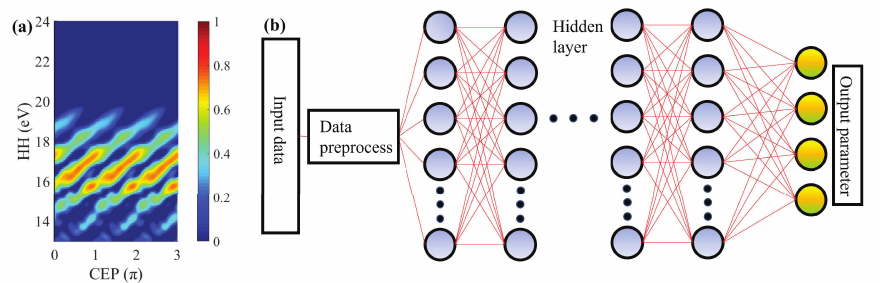
Figure 1. ( a ) CEP dependence of HHG from MgO calculated by the SBE. The theoretical calcula- tions reproduce very well the experimental results presented in [27]. For a better comparison with the experimental data, a laser with field strength of 1.2 V/ ˚A and excitation carrier wave central wavelength of 1.7 µ m, corresponding to a laser period T 0 = 5.665 fs was used. In the numerical simu- lations, a Gaussian shaped envelope with FWHM = 2 T 0 was adopted. MgO band was calculated by Equation (1) with rp 1 = 7.78, rp 2 = 4.521, rp 3 = 1.021 and rp 4 = 0.1221, respectively. ( b ) Schematic illustration of the multilayer perceptron (MLP) used in our